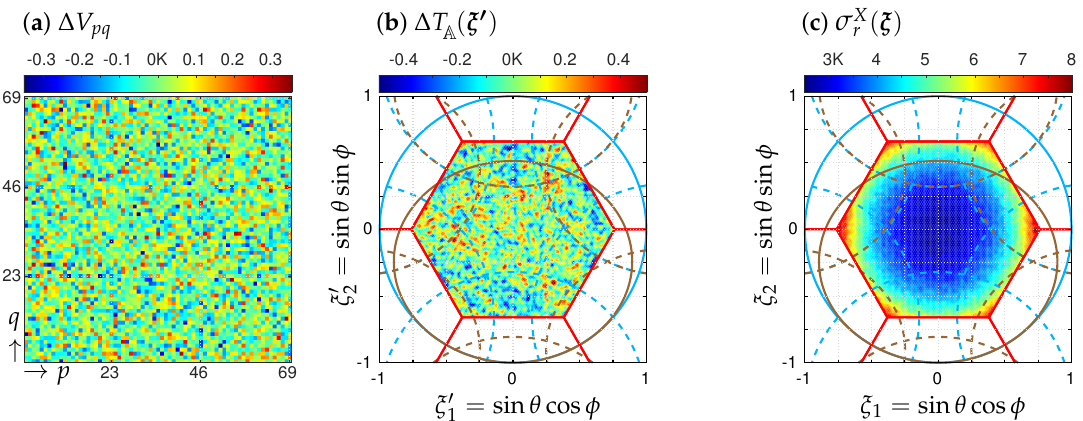
Figure 11. Examples of random Gaussian noise added ( a ) to the complex visibilities V pq or ( b ) to the antenna temperatures T A ( ξ (cid:48) ) in X polarization and ( c ) the corresponding standard deviation map σ X r ( ξ ) of 1000 error maps ∆ T X r ( ξ ) thus obtained in the synthesized field of view with either paradigm (the average map is almost equal to 0 as the Gaussian noises are zero-centered and the modeling operators are linear). Here, the standard deviation of ∆ V pq is set to 0.1 K, that of ∆ T A ( ξ (cid:48) ) is equal to 0.14 K, and the radiometric sensitivity in the boresight direction ξ = ( 0,0 ) of σ X r ( ξ ) is equal to 2.55 K. The same behavior is observed in Y